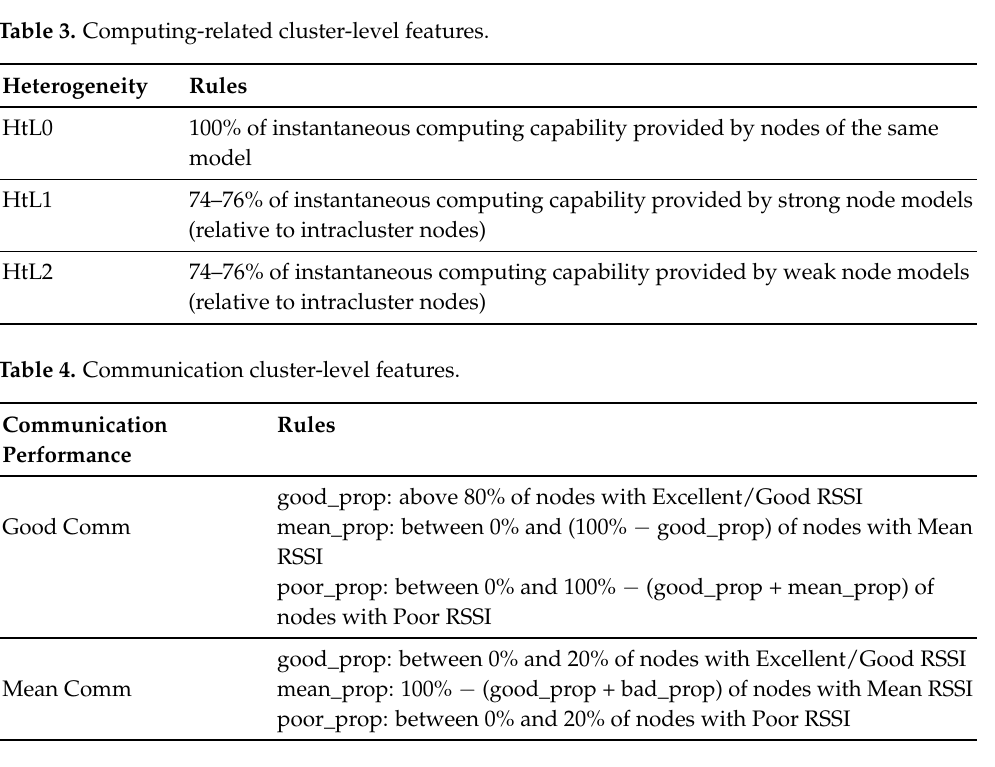
Table 5. Mapping of communication and computation cluster-level